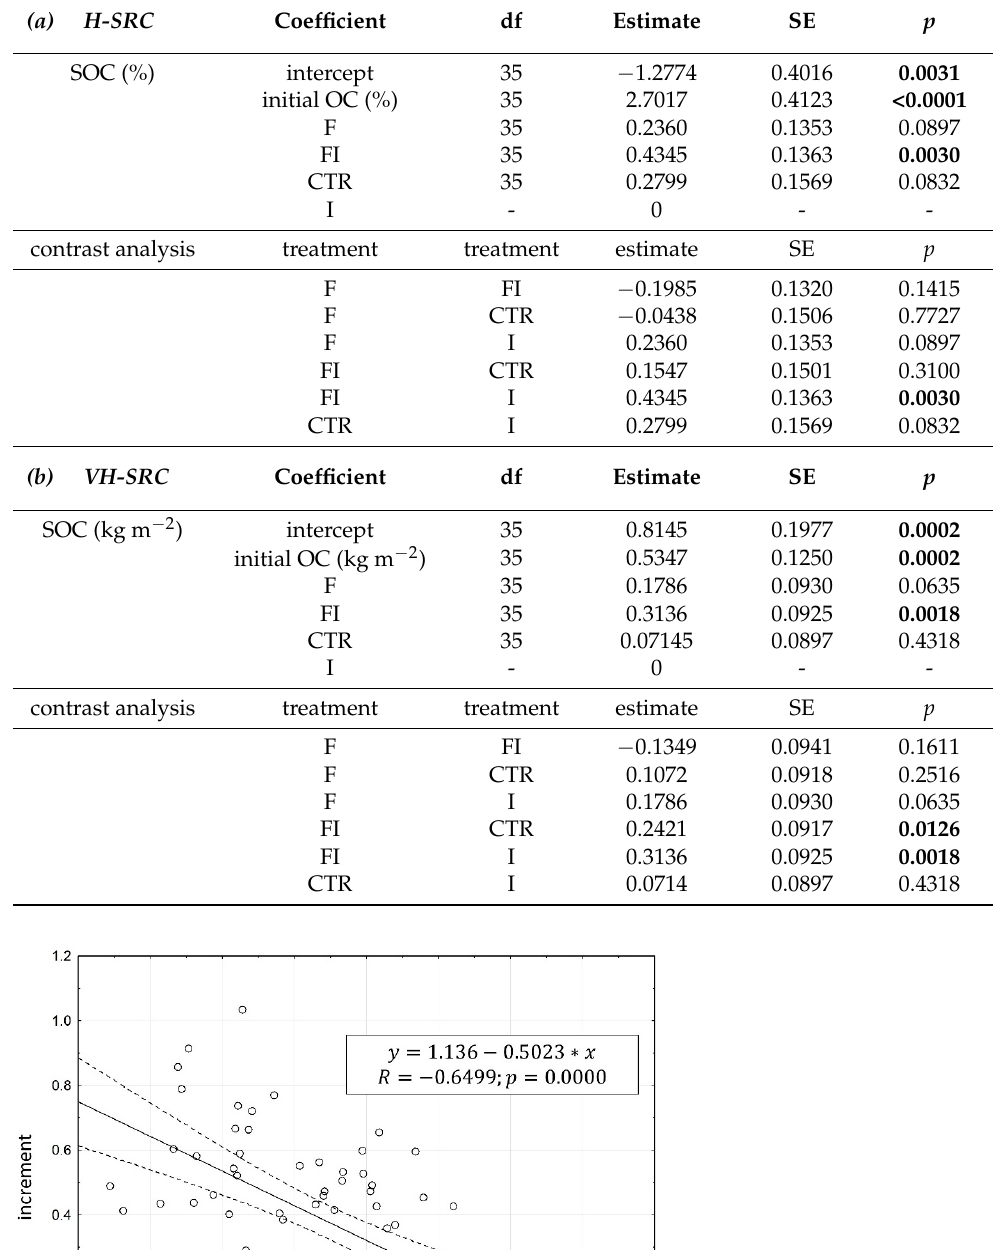
Table 3. Effects of 6 years of agronomic treatments on SOC and differences between the mean values (contrast analysis): coefficient estimates and their standard error of the models for topsoil SOC as a function of initial SOC and treatments (I: irrigation; F: fertilization; FI: fertilization and irrigation;